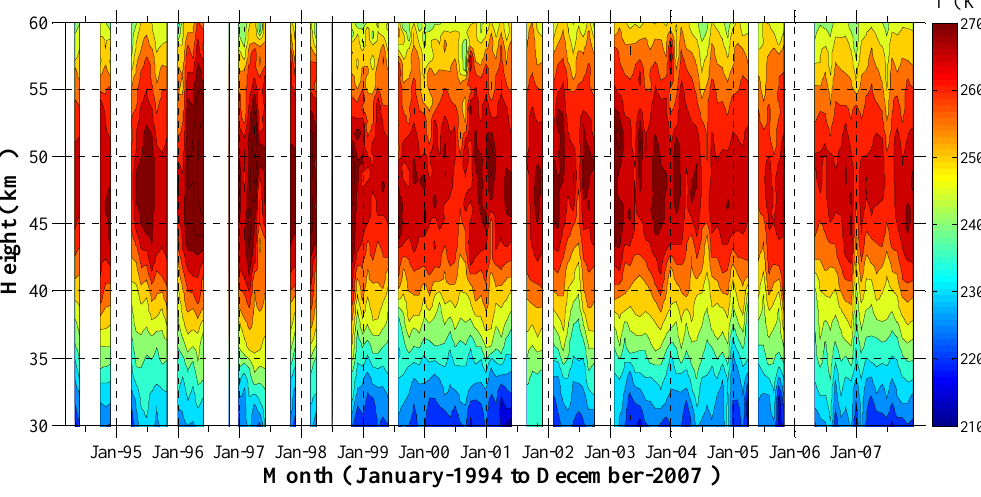
Fig. 1. Temporal evolution of monthly mean temperature obtained from LIDAR observations over Reunion Island for the period from January 1994 to December 2007. The blank spaces in the figure illustrate times during which no data was collected.